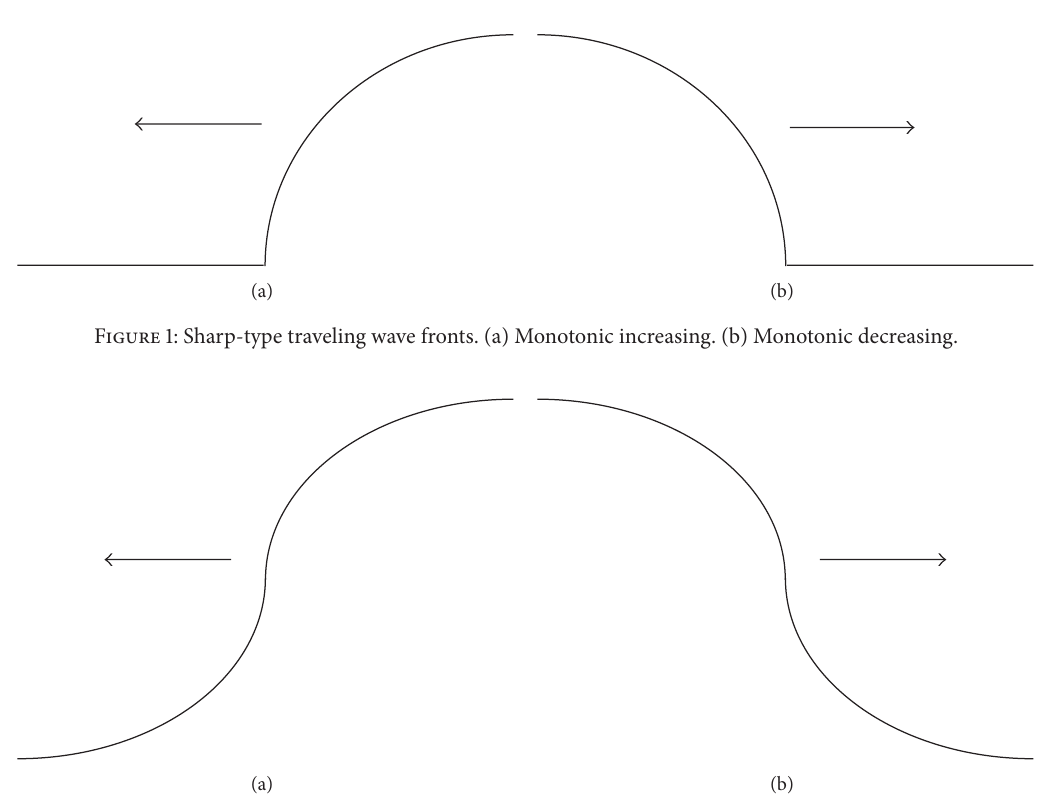
Figure 2: Smooth-type traveling wave fronts. (a) Monotonic increasing. (b) Monotonic